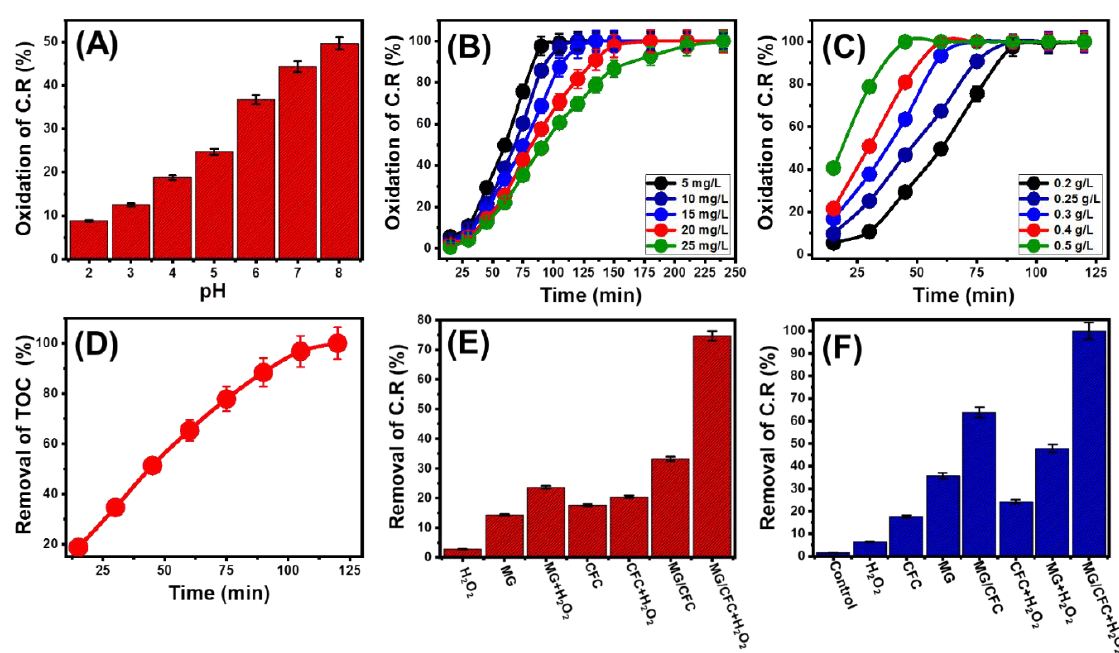
Figure 6. Shows ( A ) effect of pH on the oxidation of C.R by MG/CFC [solid dosage: 0.2 g/L; interval: 60 min; concentration: 5 mg/L; temperature: 313 K; 0.1 mL H 2 O 2 ], ( B ) oxidation behaviors of different concentrations of C.R by MG/CFC [solid dosage: 0.2 g/L; temperature: 313 K; Fenton reagent: 0.1 mL H 2 O 2 ], ( C ) effect of the MG/CFC dosages on the oxidation percentages of C.R [C.R concentration: 5 mg/L; temperature: 313 K; Fenton reagent: 0.1 mL H 2 O 2 ], ( D ) the reduction in the TOC content during the oxidation of C.R [C.R concentration: 5 mg/L; dosage: 0.5 g/L; temperature: 313 K; Fenton reagent: 0.1 mL H 2 O 2 ], ( E ) the synergetic effect of the integration processes between the components of the catalysts and hydrogen peroxide on the removal of C.R in the dark by adsorption and Fenton reactions [dosage: 0.5 g/L; test interval: 60 min; temperature: 313 K; and C.R concentration: 5 mg/L], and ( F ) the synergetic effect of the integration processes, visible light, and hydrogen peroxide on the removal of C.R by photocatalytic and photo-Fenton ’ s oxidation processes [dosage: 0.5 g/L; test interval: 60 min; temperature: 313 K; and C.R concentration: 5 mg/L].